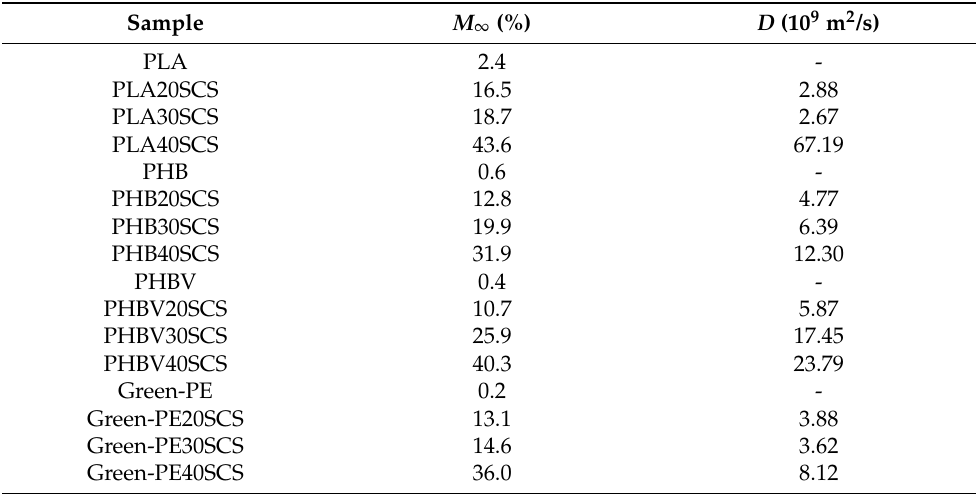
Table 3. Maximum water uptake of the materials and biocomposites diffusion coefficients calculated with the hindered diffusion